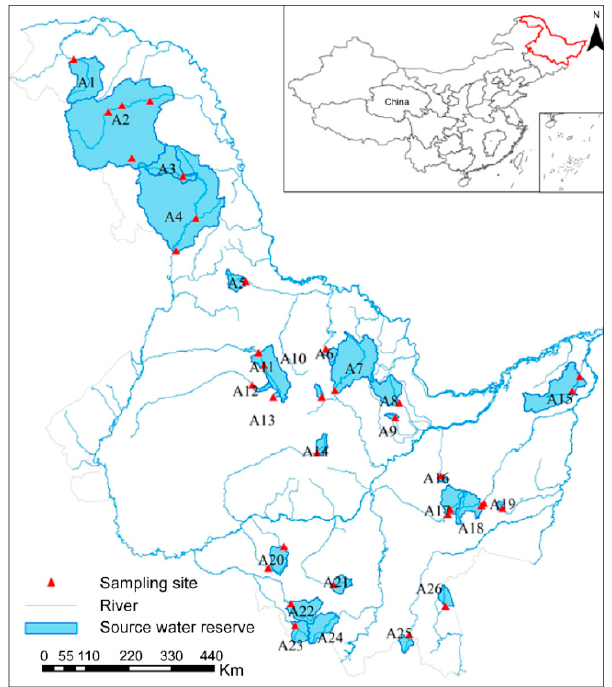
Figure 1. Distribution of river source water environment function zones and sampling sites.